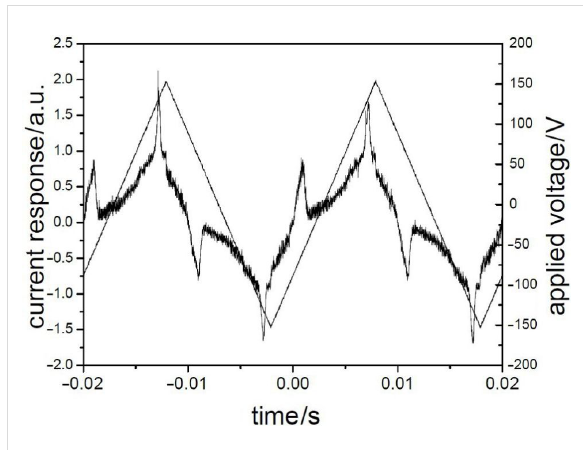
Figure 23: Current response of compound OH 6b exhibiting two repo- larisation peaks proving an antiferroelectric switching ( U A.C. = 15 V/ µm, f = 50 Hz, T = 174 °C, d cell = 6 μ m).